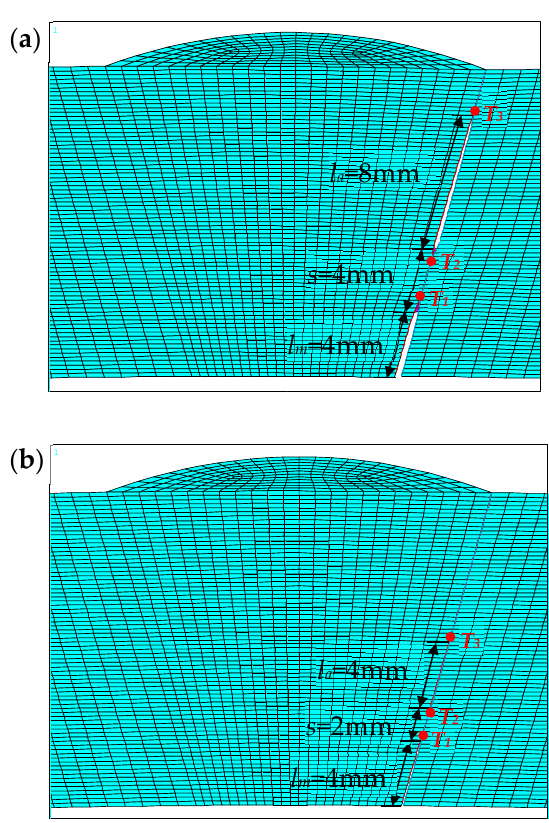
, , ( b ) 𝛾 (cid:3039) = 1 ， 2 2